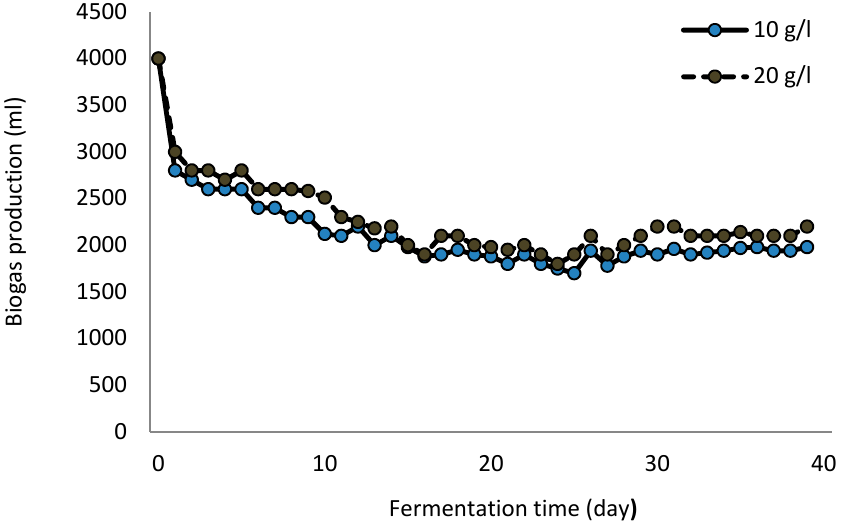
Figure 2. Biogas production (mL) of 10 g/L and 20 g/L sugar loading over fermentation time (day) with 2 days HRT in sequencing mode reactor.